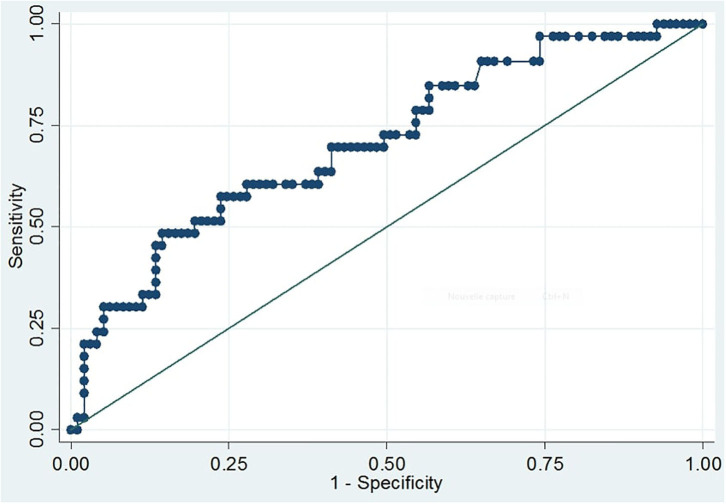
ROC curve of S100B serum levels for prediction of intracranial injury revealed by CT scans. The curve depicts the sensitivity and one-specificity values calculated for each individual serum S100B concentration with respect to the radiological findings of the initial CT scan. The quality of the discriminative potential is expressed by the AUC, which was 0.71 (95% CI, 0.60–0.81; p < 0.001).